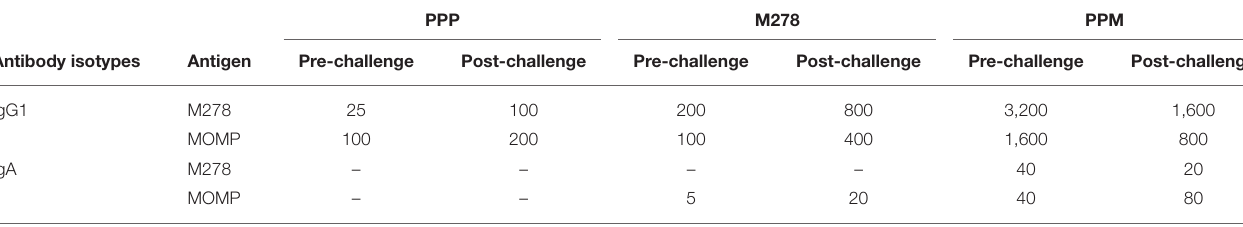
TABLE 2 | Mucosal antibody endpoint titers of immunized